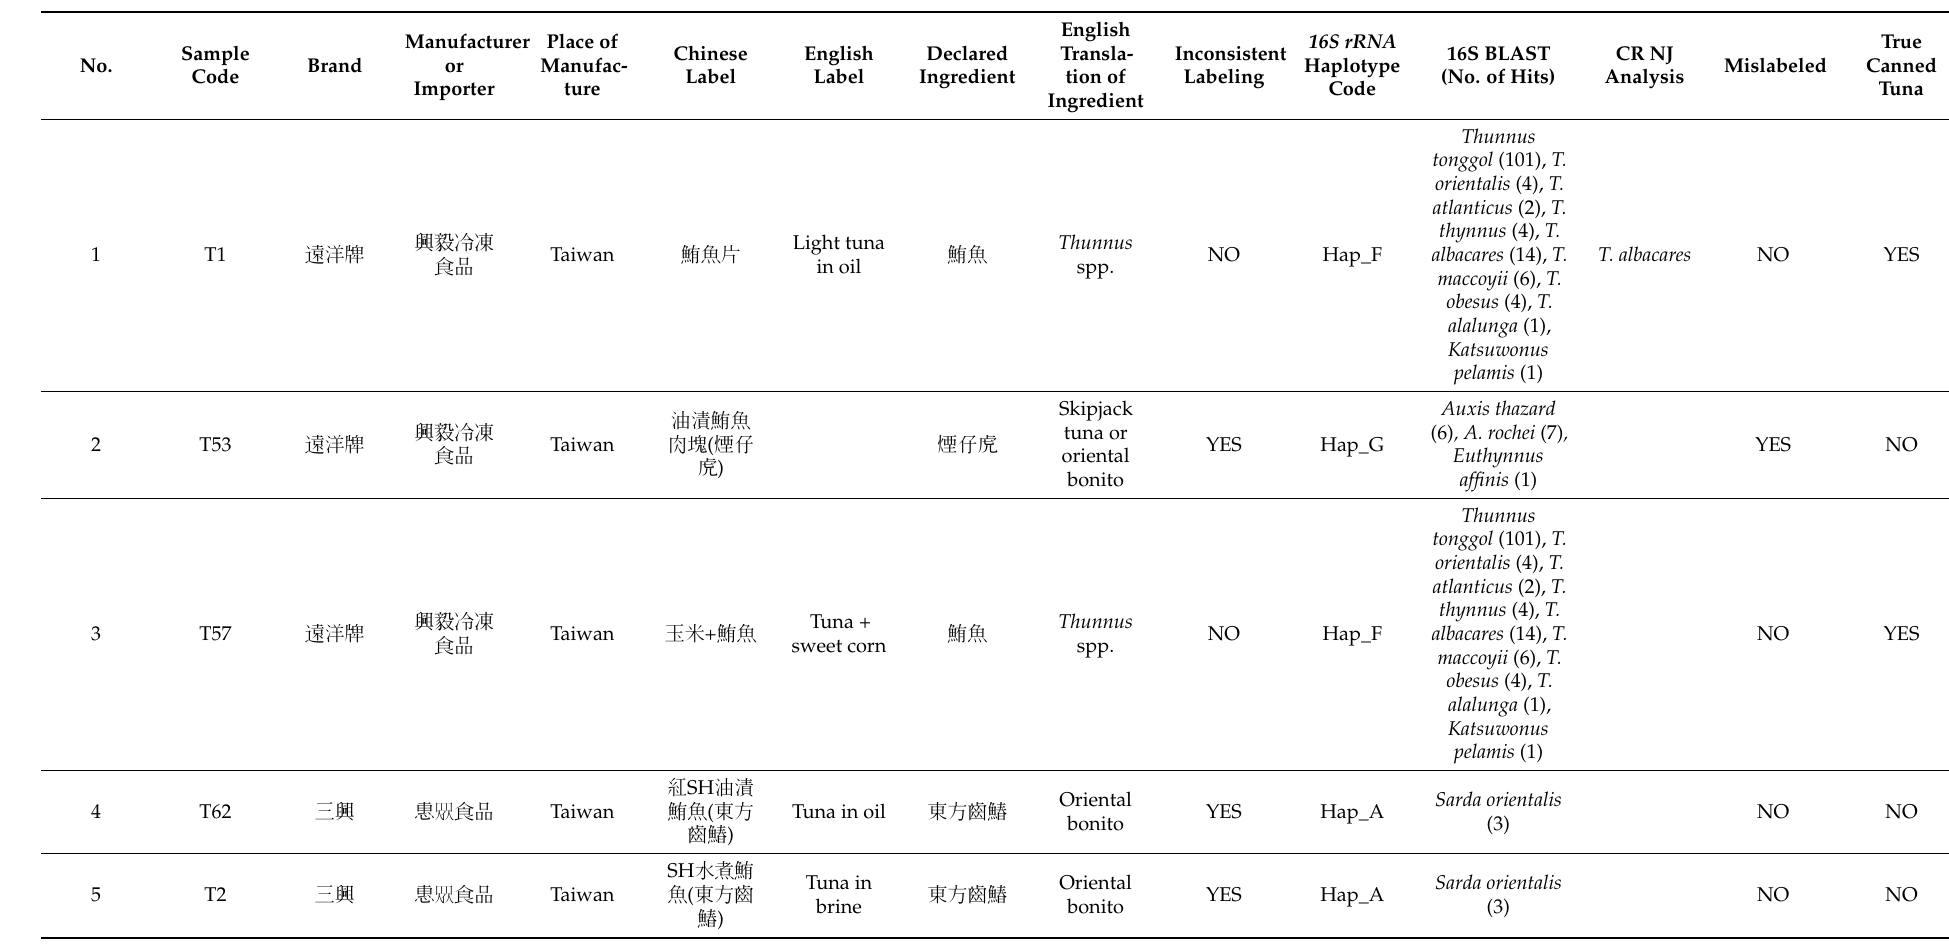
Table 2. List of all canned tuna product samples authenticated by 16S rRNA BLAST and the results of neighbor-joining (NJ) analysis based on the mitochondrial control region (CR).